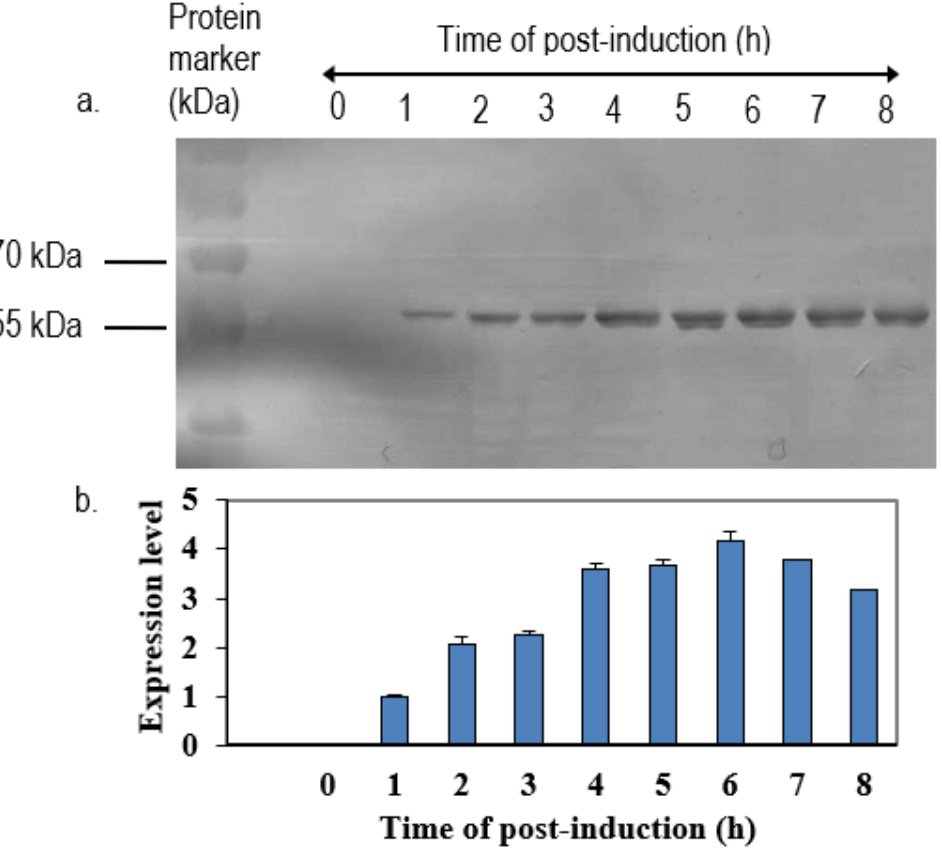
Figure 7. Time-course expression of the NPt-VP1 198–297 in E. coli TOP10 after induction of IPTG. The cultures were collected at time points of 0 h, 1 h, 2 h, 3 h, 4 h, 5 h, 6 h, 7 h, and 8 h post-induction with IPTG. ( a ) Immunoblotting of expressed protein by anti-His monoclonal antibody. ( b ) The expression level of recombinant proteins was detected from the immunoblotted bands of expressed proteins by using ImageJ software. The expression of protein reached the peak level on 6 h post-induction.